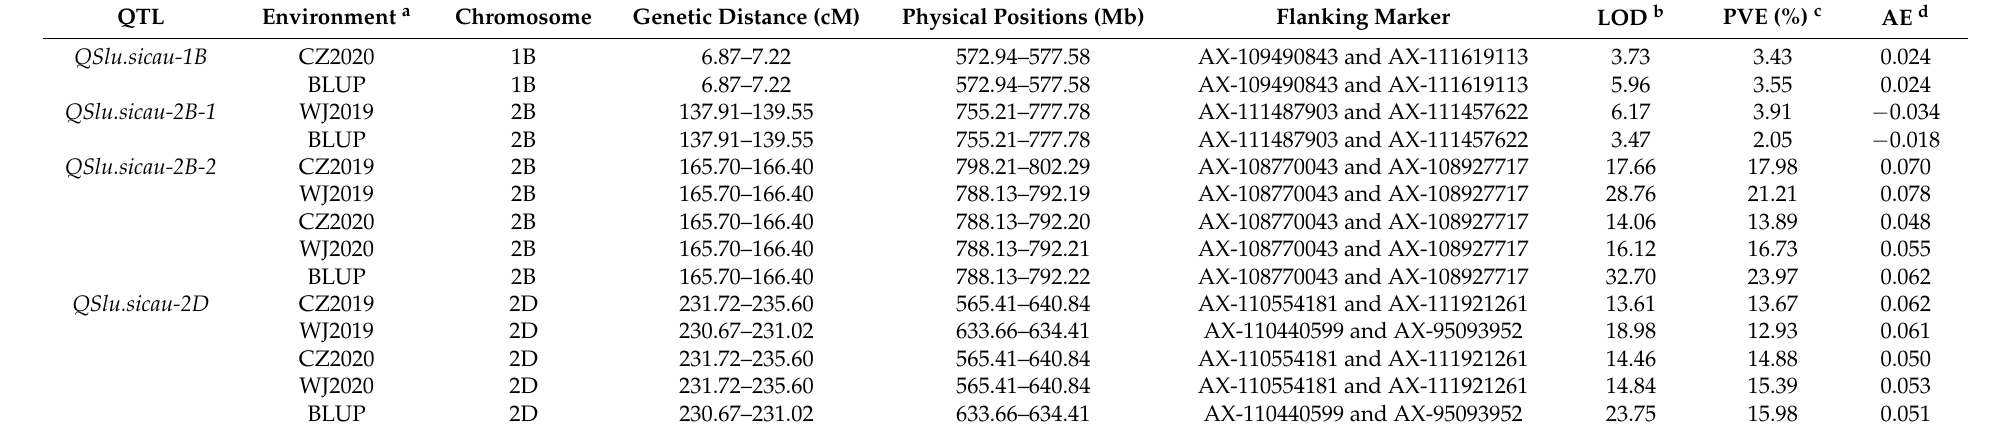
Table 3. Quantitative trait loci for spike-layer uniformity that were identified in different environments and using BLUP